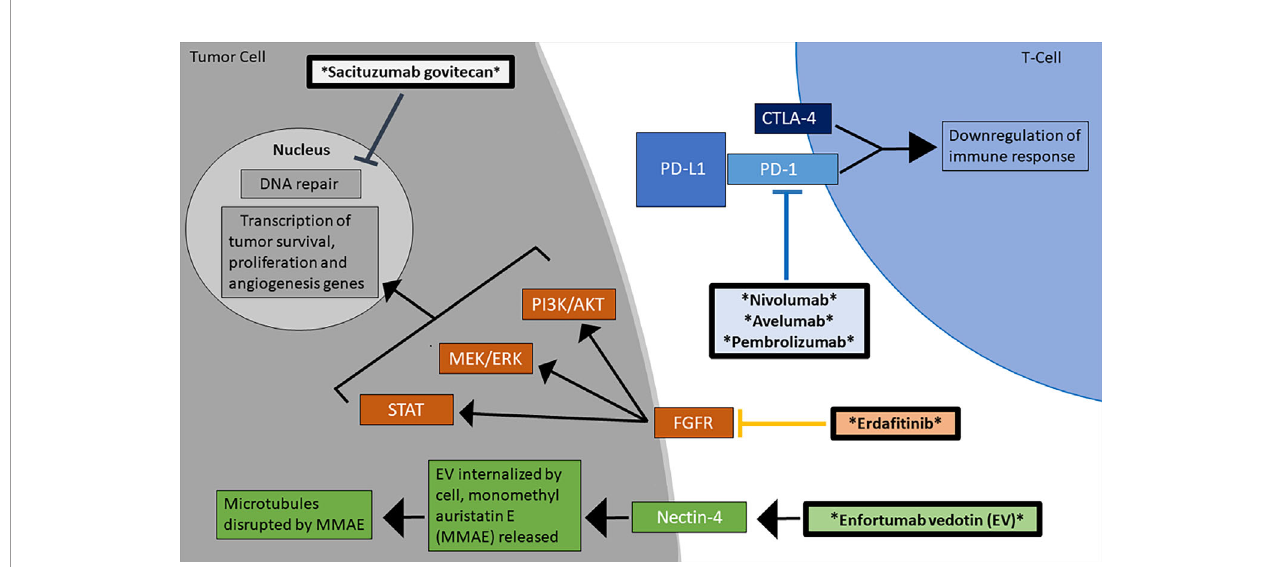
FIGURE 1 | Mechanisms of action for the FDA-approved treatments for advanced/metastatic urothelial carcinoma. There are currently 6 FDA-approved agents for the treatment of MIBC, which work through diverse mechanisms, including checkpoint inhibition and blockage of the FGFR signaling pathway (16). The therapeutic agents are marked by asterisks and are in bolded boxes.